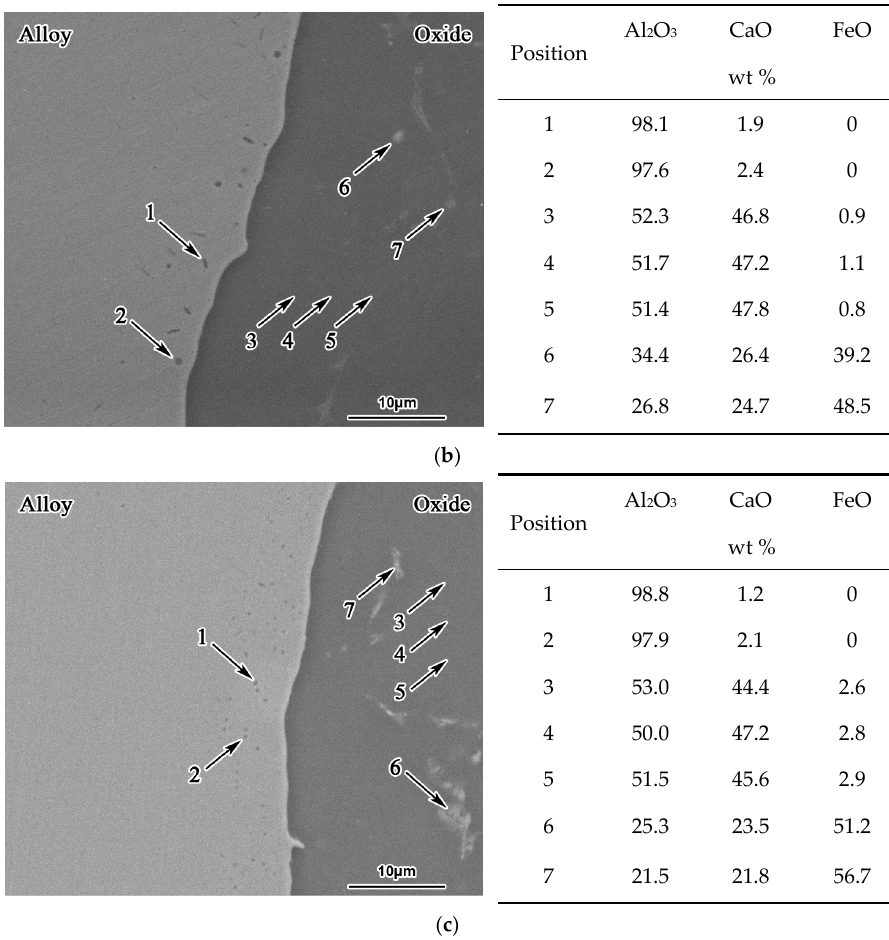
Figure 4. Morphology of interface between the alloy and oxide in the diffusion couple of G0, G1, and G2 after the oxide pre-melting experiment: ( a ) G0-0; ( b ) G1-0; ( c ) G2-0.